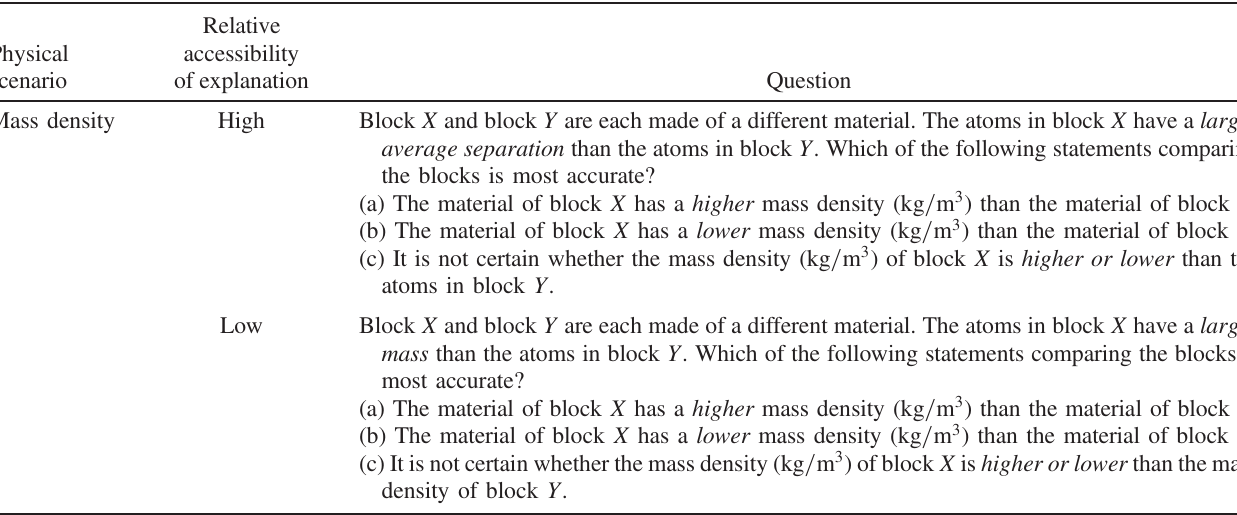
TABLE XVI. Experiment 3 multiple choice (predictive) answer format questions. Participants answered either a high or low accessibility explanation for each